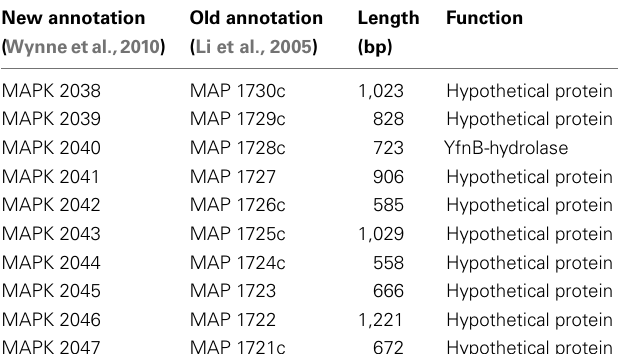
Table 3 |A list of genes in the 11kb island which is absent in M. avium 104.